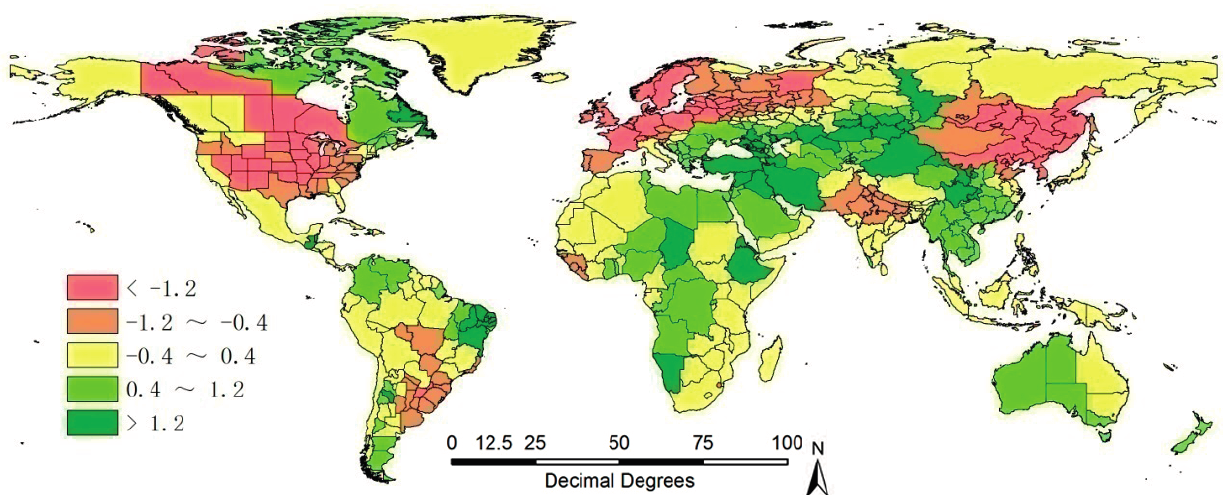
Figure 6. January to April 2013 global map of temperature departure from the 2002–2012 average, by country and administrative subdivisions within large countries; the difference is expressed as degrees Celsius (°C).